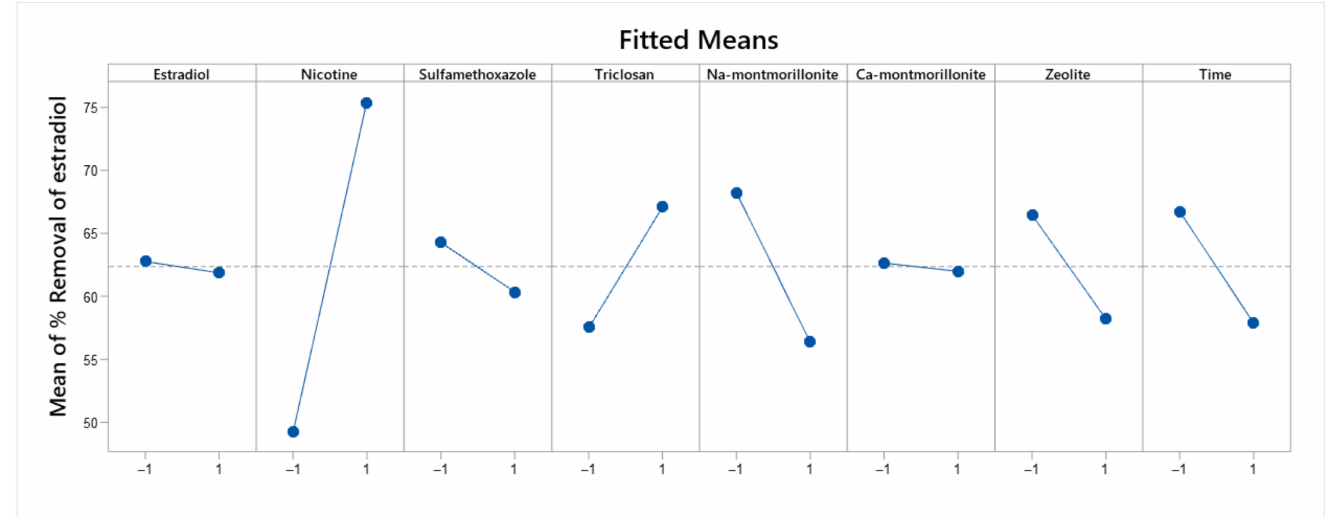
Figure 3. Fitted means effect of each factor involved in estradiol